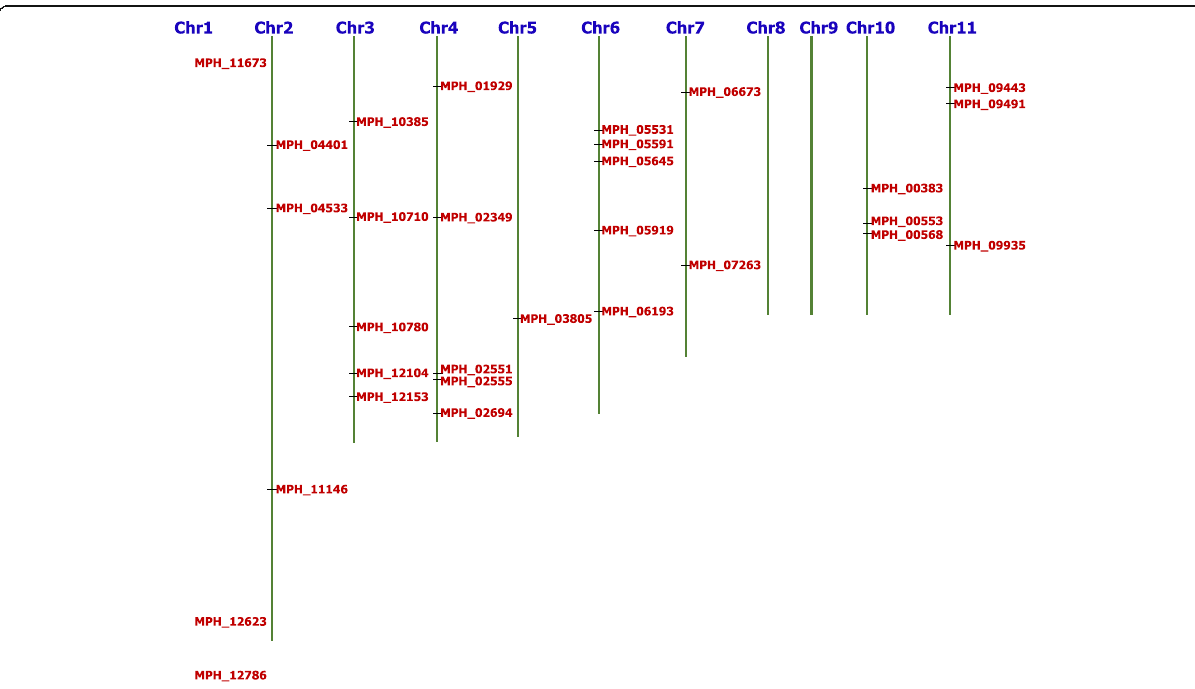
Fig. 2 Chromosomal distribution of Macrophomina phaseolina F-box